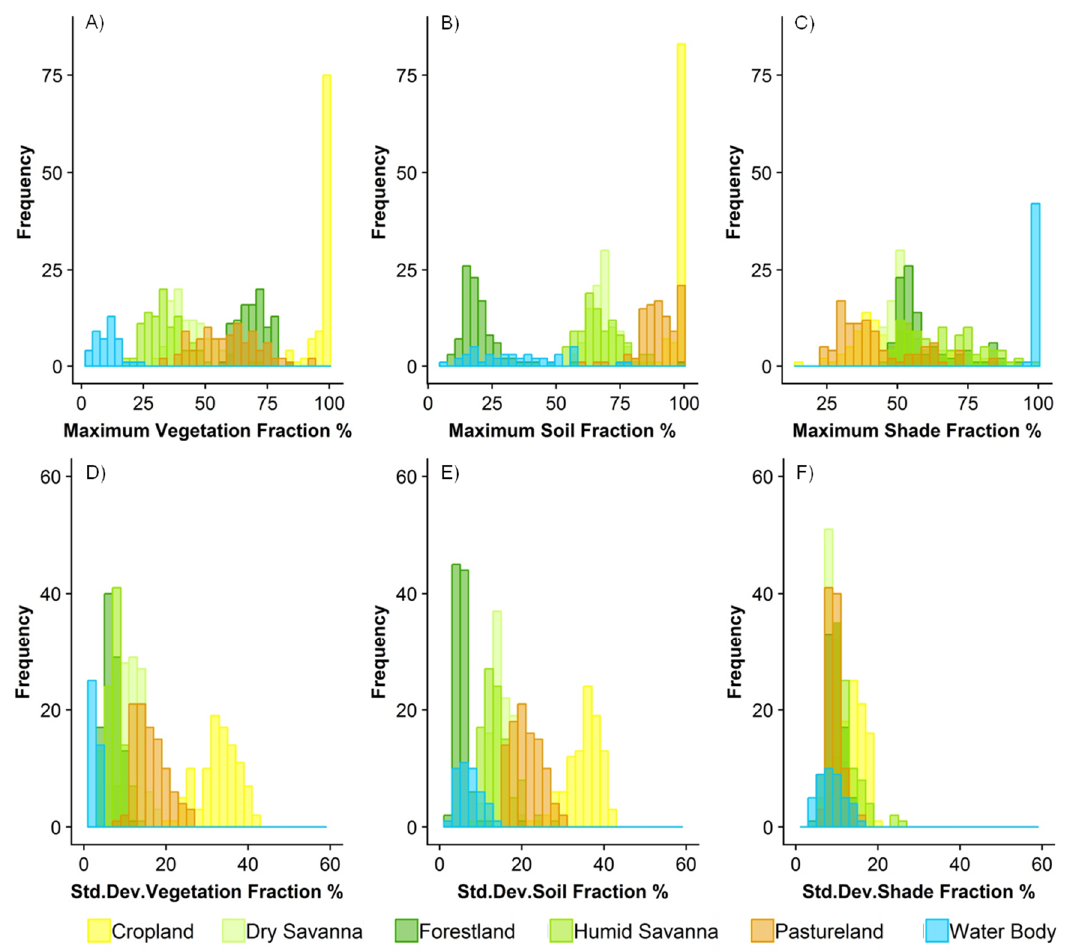
Figure 6. Maximum vegetation ( A ), maximum soil ( B ), and maximum shade ( C ) fractions of the one-year composite mosaic of the land use and land cover classes of Mato Grosso state and their corresponding standard deviations of the vegetation ( D ), soil ( E ), and shade ( F ) fractions.